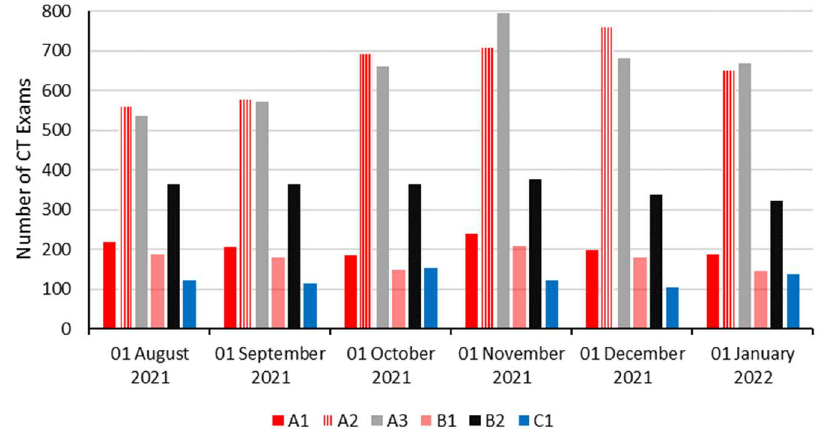
Figure 2. Demonstrates the total number of studies per institute per scanner for patients undergone CT studies across the 6 CT scanners during the 6-month period.